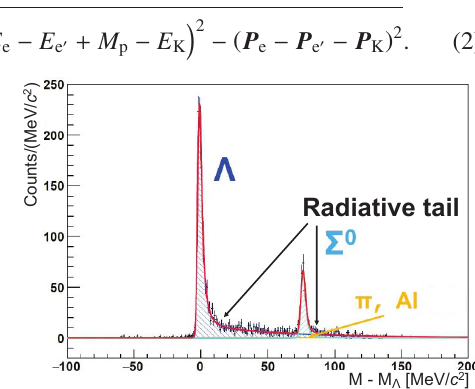
Figure 1. Missing mass spectrum obtained by the p ( e , e  K + ) X reaction. It was fi tted to estimate num- ber of hyperons including radiative tails (see